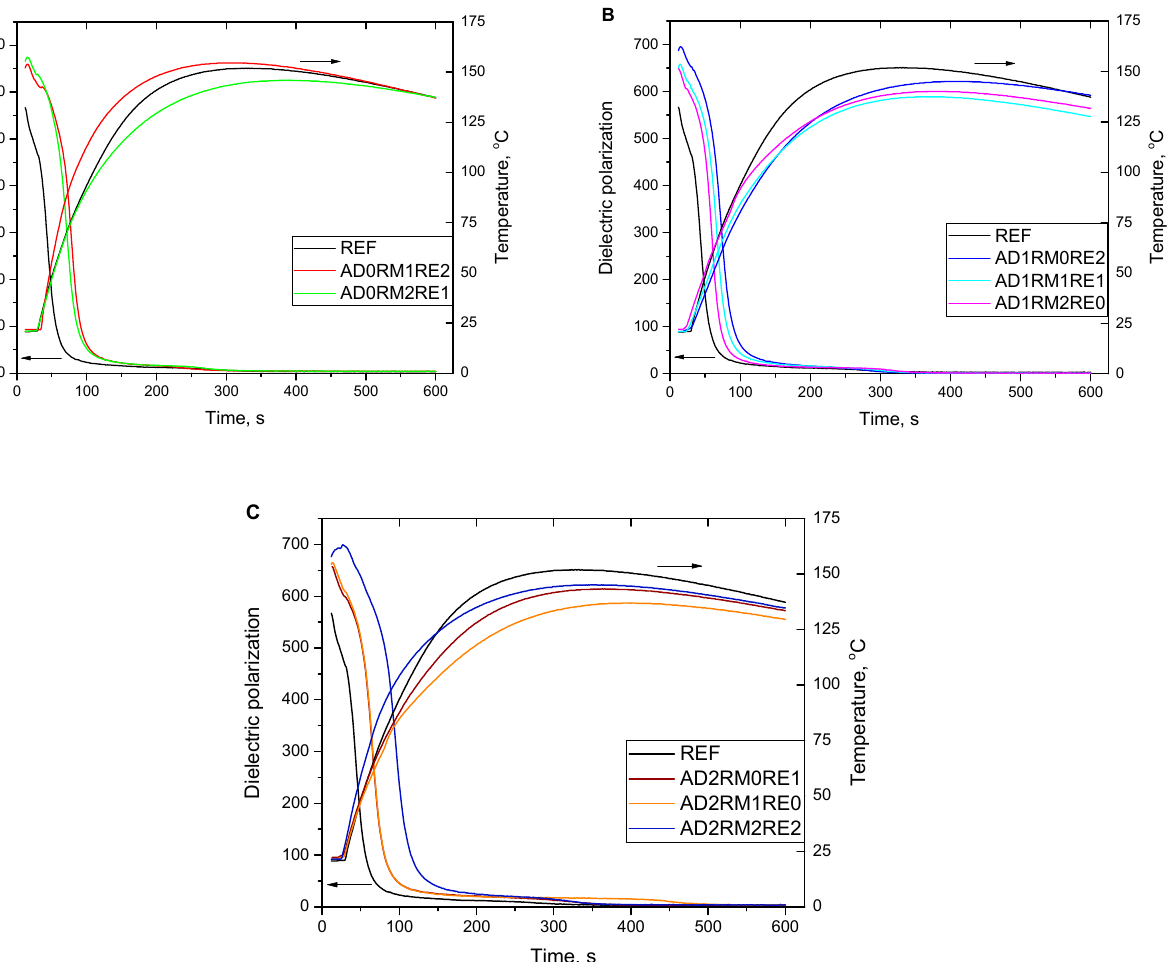
Figure 1. Change of the dielectric polarization and the temperature of the foam core during the foaming process of the tested polyurethane systems.